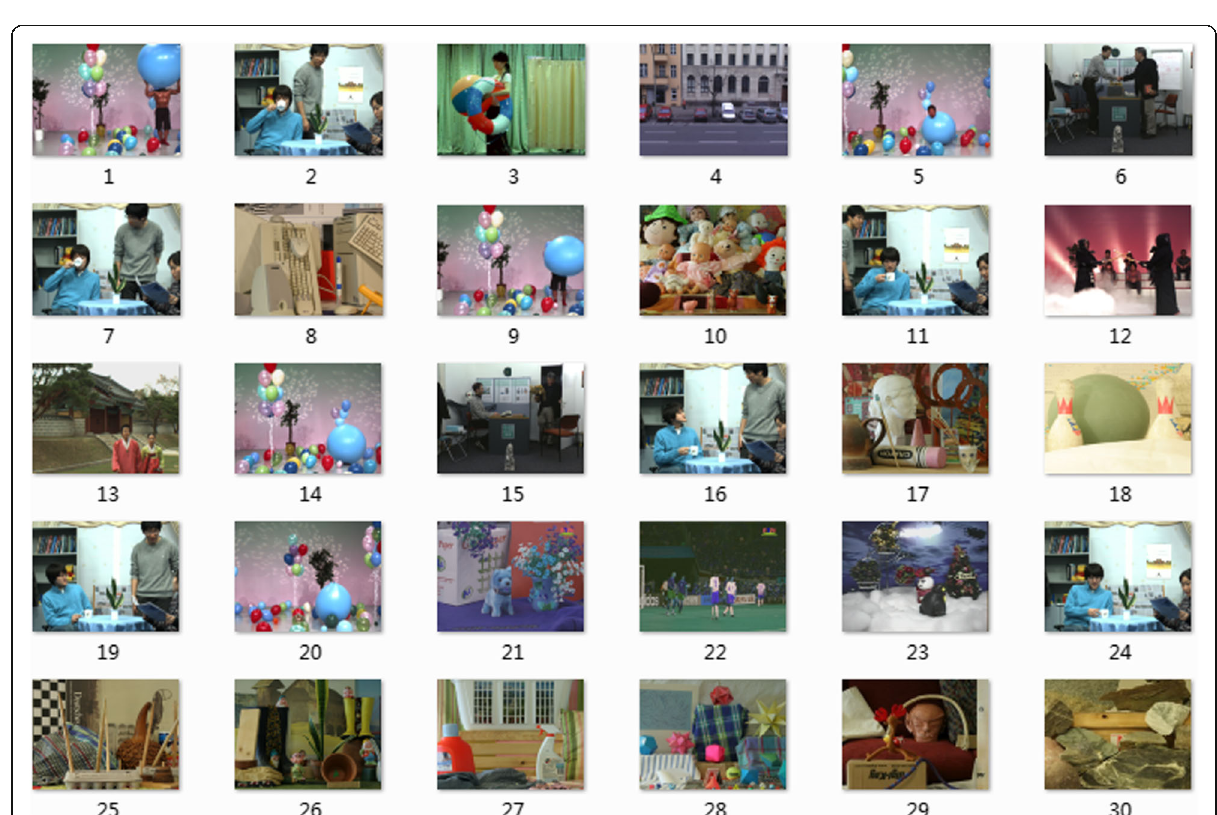
Fig. 6 Thirty left view images of the natural stereoscopic image set for